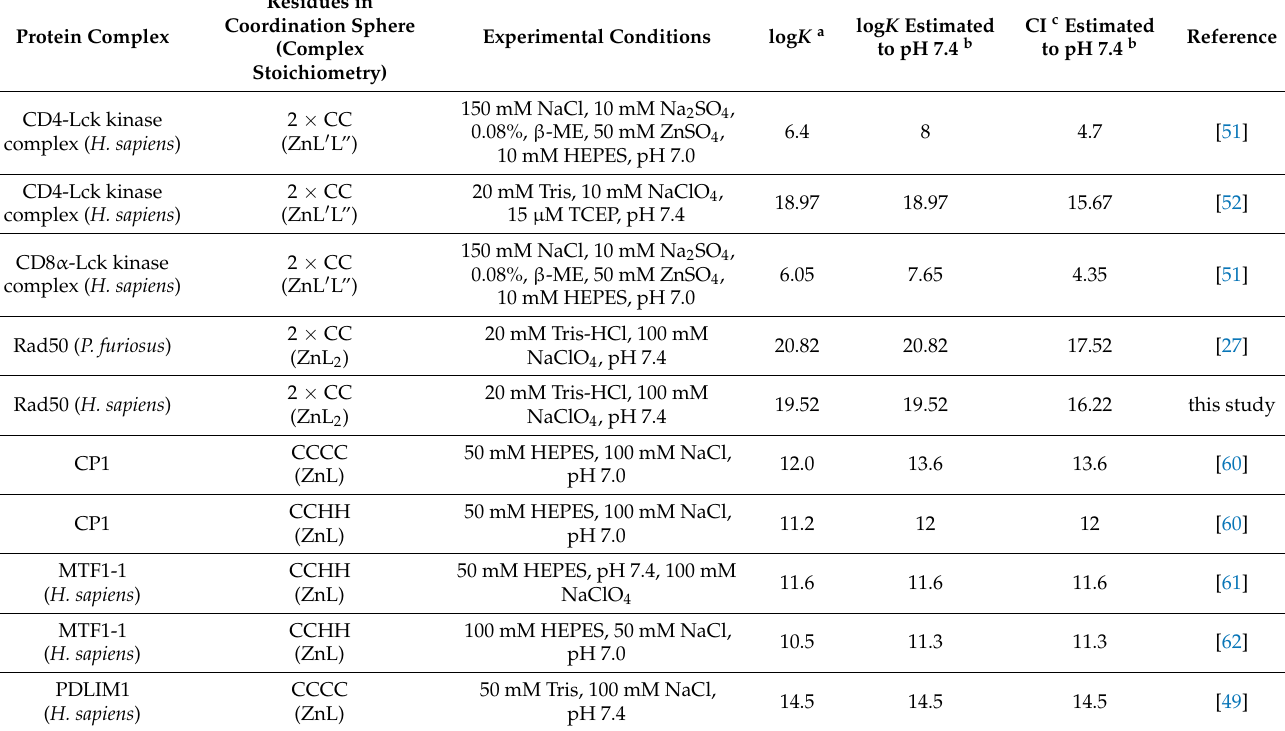
Table 2. Conditional formation constants for selected Zn(II) binding proteins or peptides with details of experimental conditions found across the literature. Some of the presented polypeptides form complexes of stoichiometry 1:2 Zn(II):polypeptide, which is